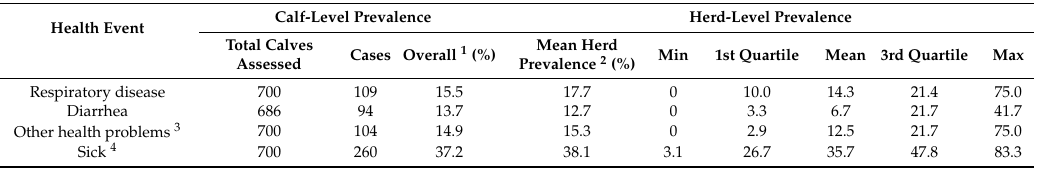
Table 3. Calf and herd-level prevalence (%) of respiratory disease, diarrhea, and other health problems on 29 dairy farms using group pens in Los R í os region, Chile.